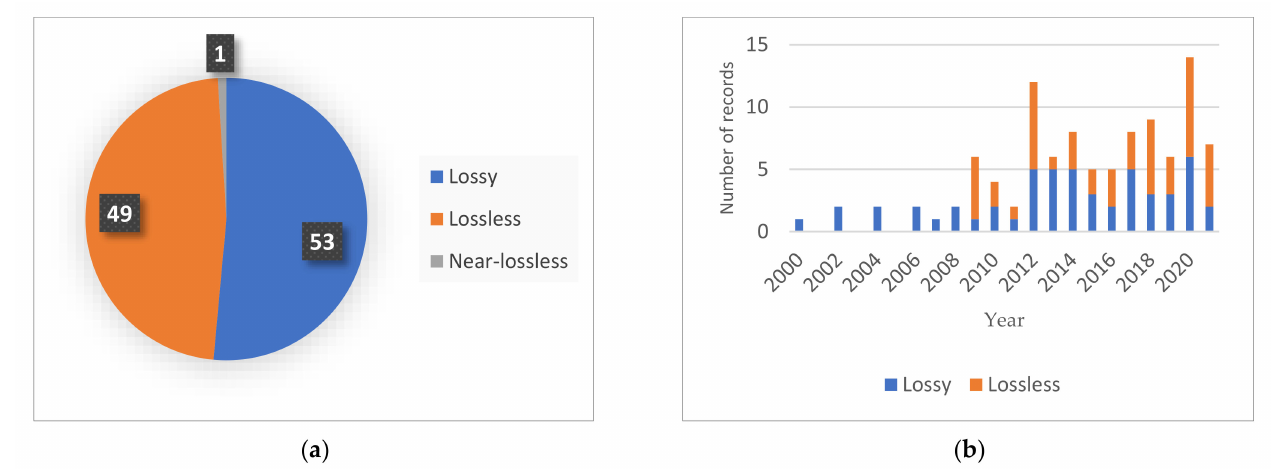
Figure 4. ( a ) Chart representing the number of records in different types of compression algorithms of HSI; ( b ) Temporal evolution of the distribution of number of records in each of the two major compression types (lossy and lossless) from the year 2000 to part of